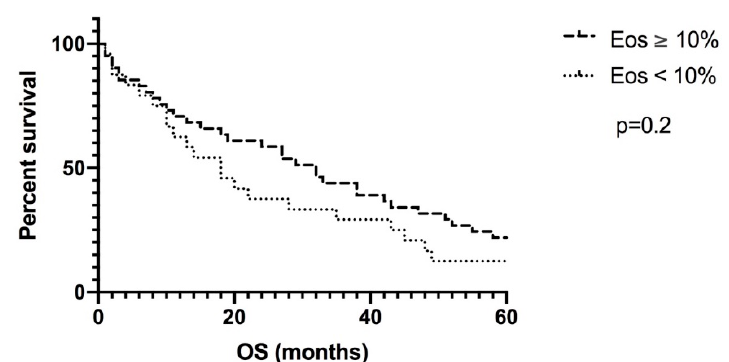
Figure 3 . Intention-to-treat analysis for a cut-off of 10% eosinophils in peripheral blood. With a cut- off at a percentage of eosinophils of 10%, the median OS for patients with eosinophilia greater than 10% ( n = 41) was 32 months, compared with 18 months for patients with less than 10% eosinophils ( n = 26). Eos: eosinophilia; OS: overall survival.